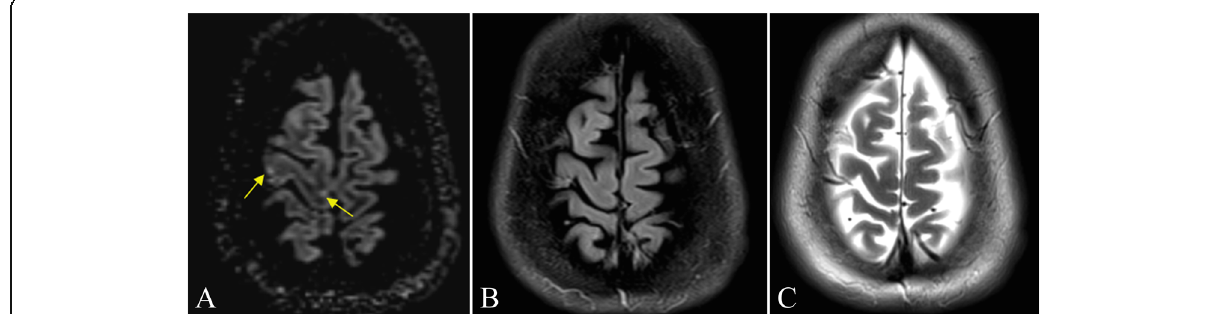
Fig. 4 Axial MRI of the brain at DIR ( a ), FLAIR ( b ), and T2WI ( c ) displaying two small hyper-intense cortical lesions on DIR sequence and not observed at corresponding FLAIR and T2W images